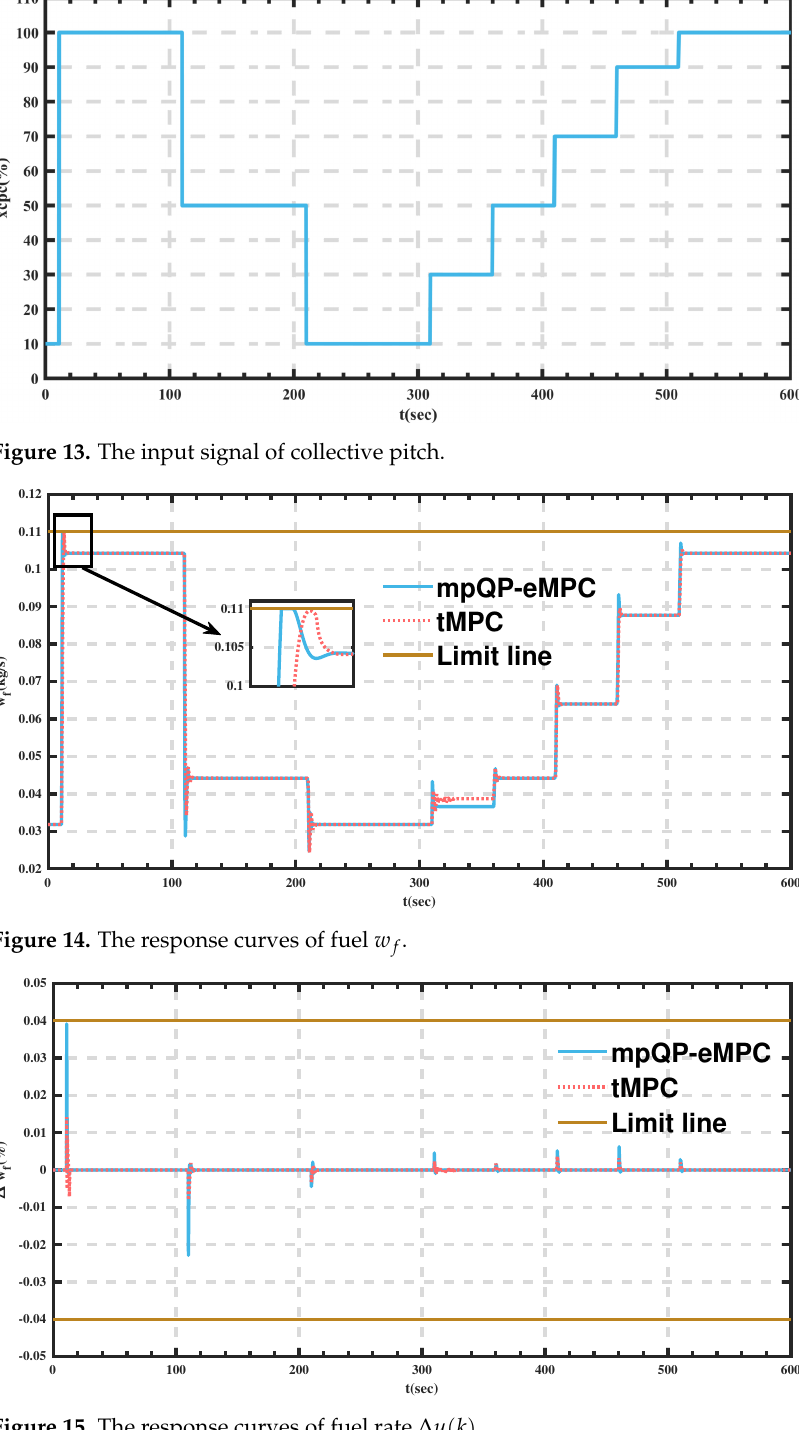
Figure 15. The response curves of fuel rate ∆ u ( k )